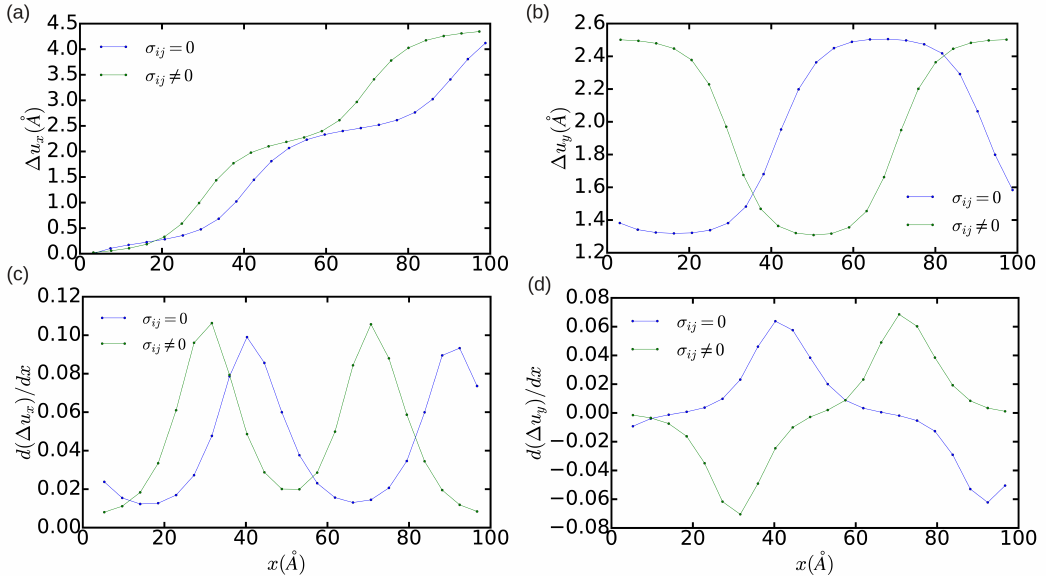
Figure 3. Relative displacement ( a , b ) and differential displacement ( c , d ) of the atoms above and below the glide plane of the edge dislocation in the x and y directions. The simulation cell contains n = 18,424 atoms. Green and blue lines represent the results obtained in a non-relaxed ( σ ij (cid:54) = 0) and a fully relaxed ( σ ij = 0) simulation cell, respectively.